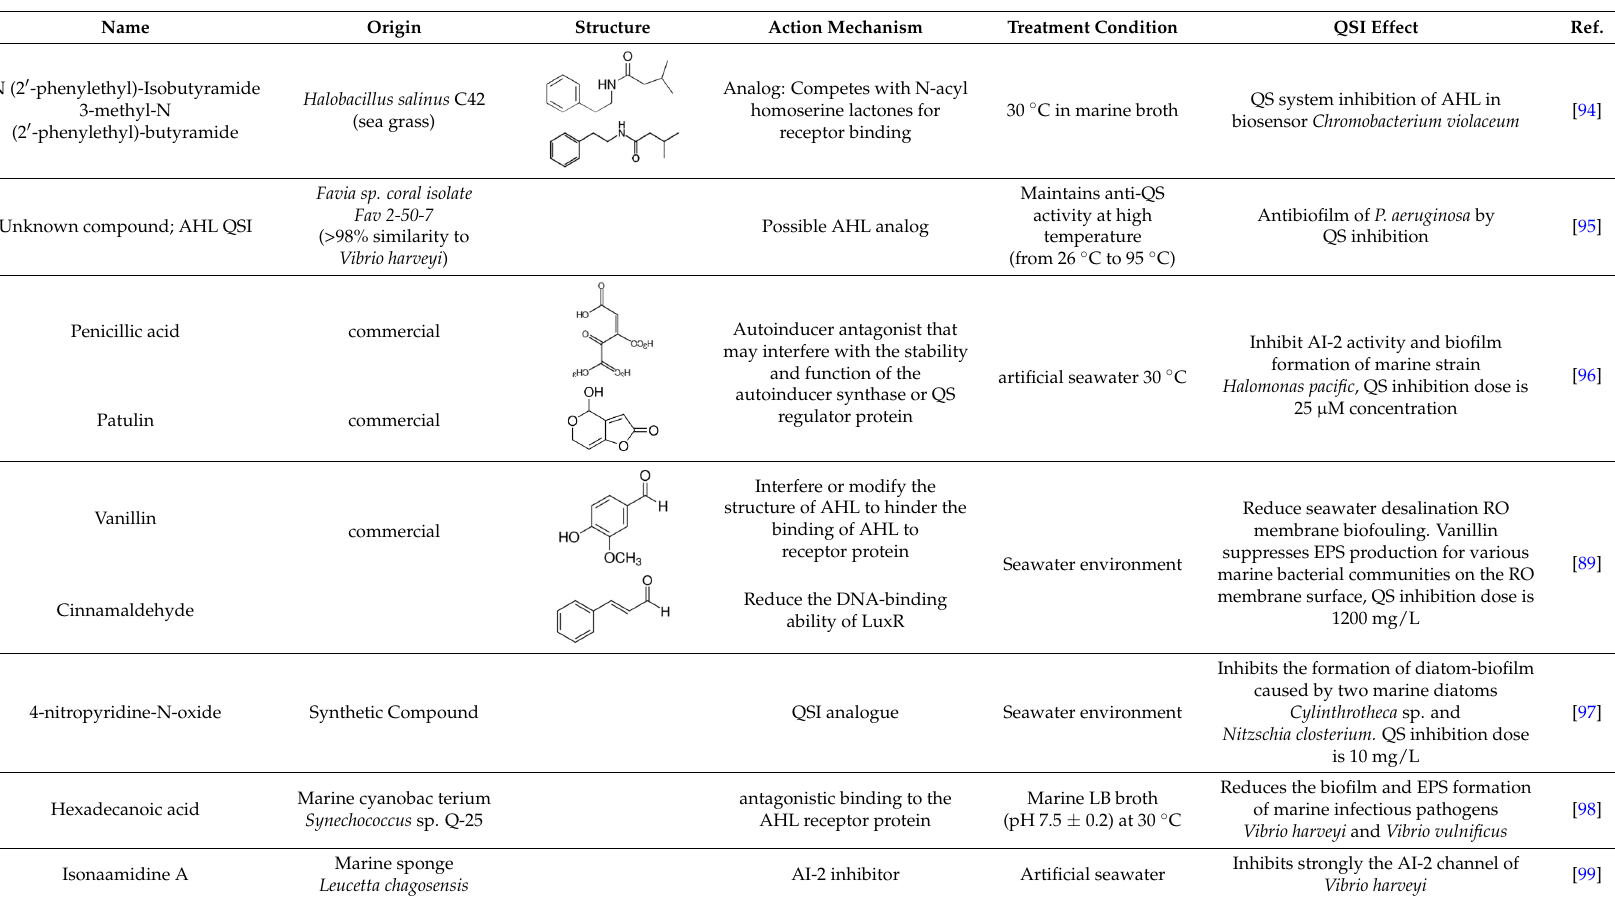
Table 4. Natural or synthetic compounds with demonstrated quorum quenching effects in thermophilic or halophilic conditions. QSI denotes quorum sensing inhibitor.